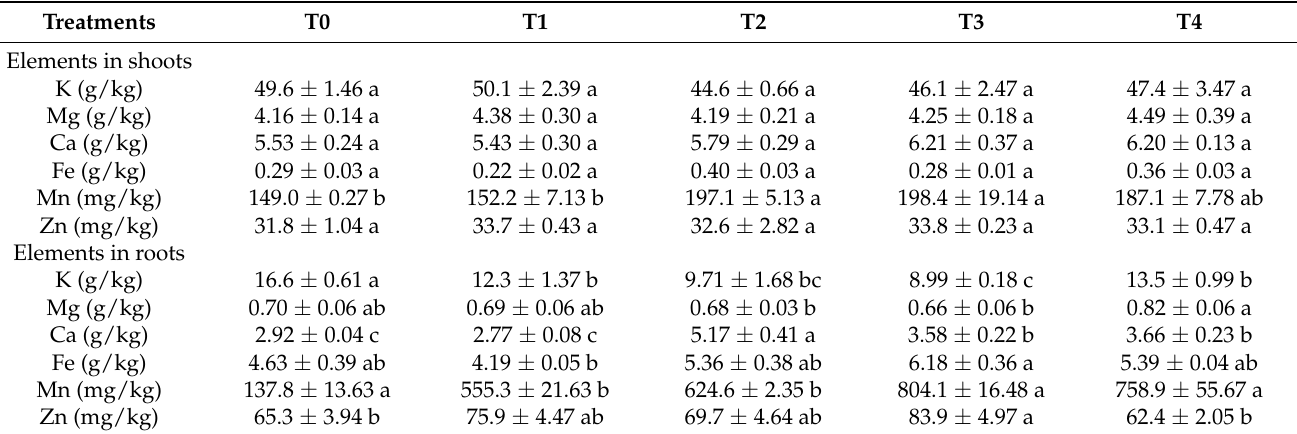
Table 1. Effects of chlorinated amino acetic acid on mineral elements in X24 rice seedlings.